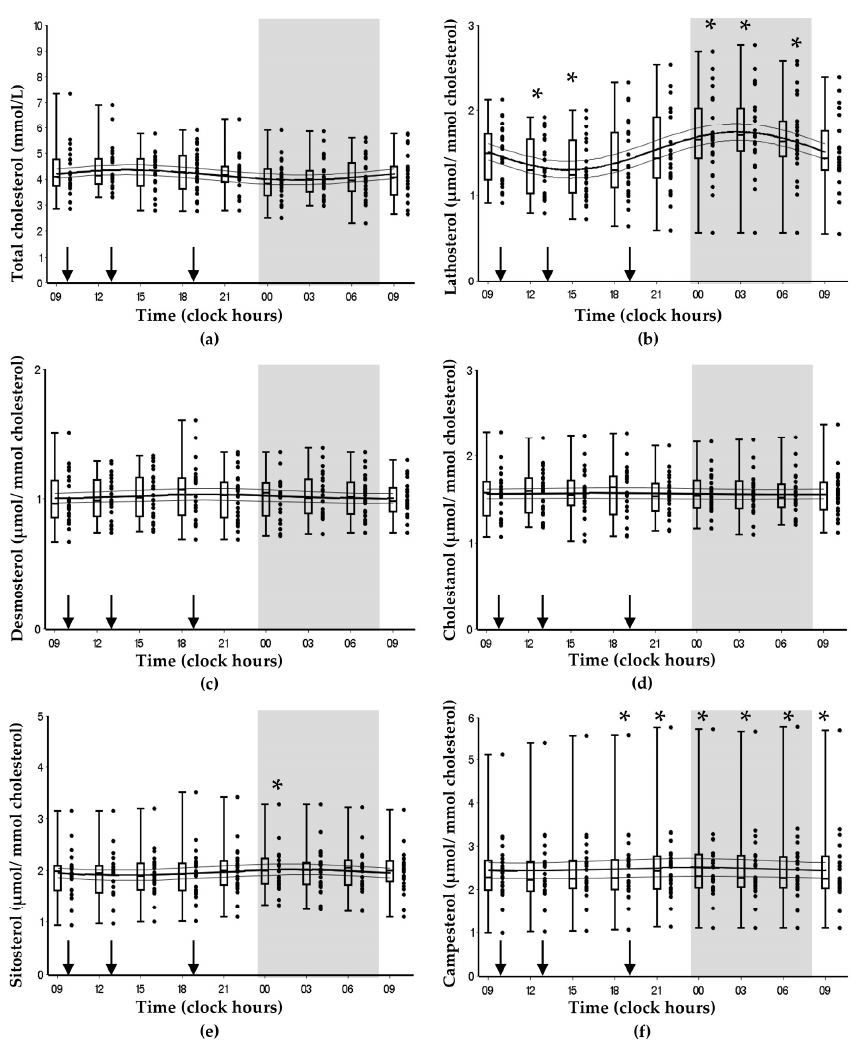
Figure 6. The diurnal rhythms of: ( a ) total cholesterol ( cosinor p = 0.070), ( b ) lathosterol ( cosinor p < 0.001), ( c ) desmosterol ( cosinor p = 0.640), ( d ) cholestanol ( cosinor p = 0.950), ( e ) sitosterol ( cosinor p = 0.460), and ( f ) campesterol ( cosinor p = 0.890) in healthy males ( n = 24). Data are presented as cosinor curves with confidence bounds. The dots next to the boxplots indicate individual data points. The grey area indicates the sleeping period and the arrows indicate meal timing. * Indicates significant difference ( p < 0.05) compared with 09:00 h on day 1 using Bonferroni post hoc tests following significant time-effects using a linear mixed model.